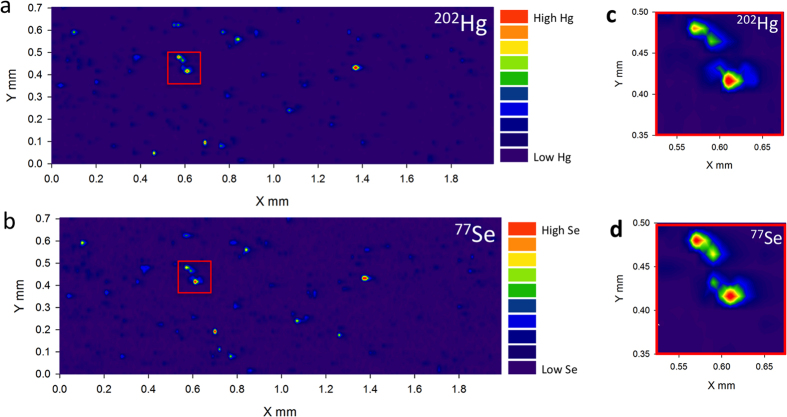
In vivo formation of HgSe nanoparticles.2D map of Hg (a) and Se (b) distribution in the brain tissue of an adult whale generated by LA-ICP-MS. Co-localisation of Hg and Se hotspots suggests formation of particles containing both elements (c,d). The legend indicates the intensity of monitored m/z in counts per second (cps) with the lowest intensity represented by blue colour and the highest intensity in red colour.